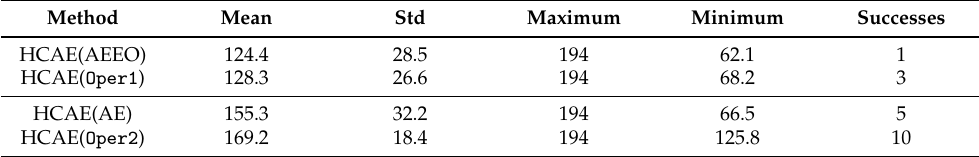
Table 4. Results of the second phase of experiments—TSP.